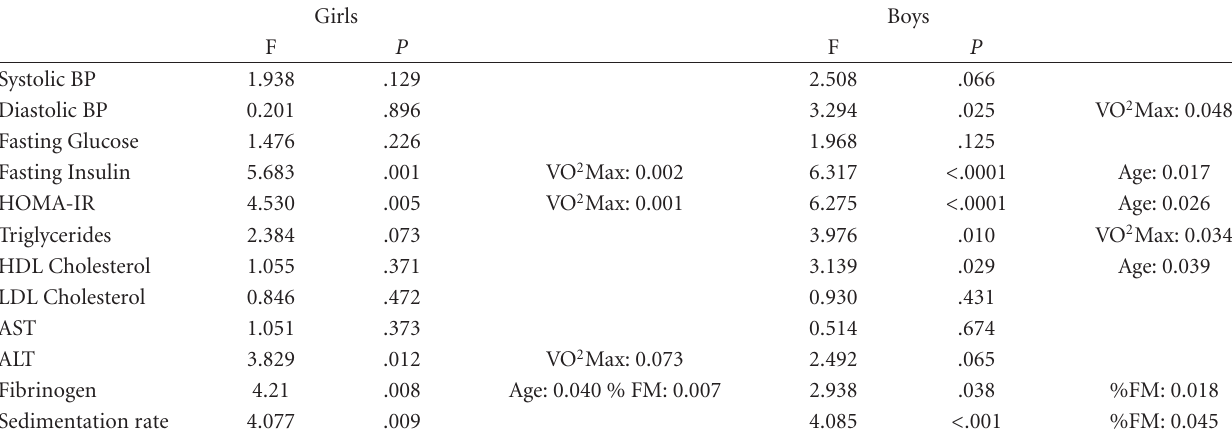
Table 3: Multivariate regression between metabolic risk factors and VO 2 Max, using age and % fat mass as